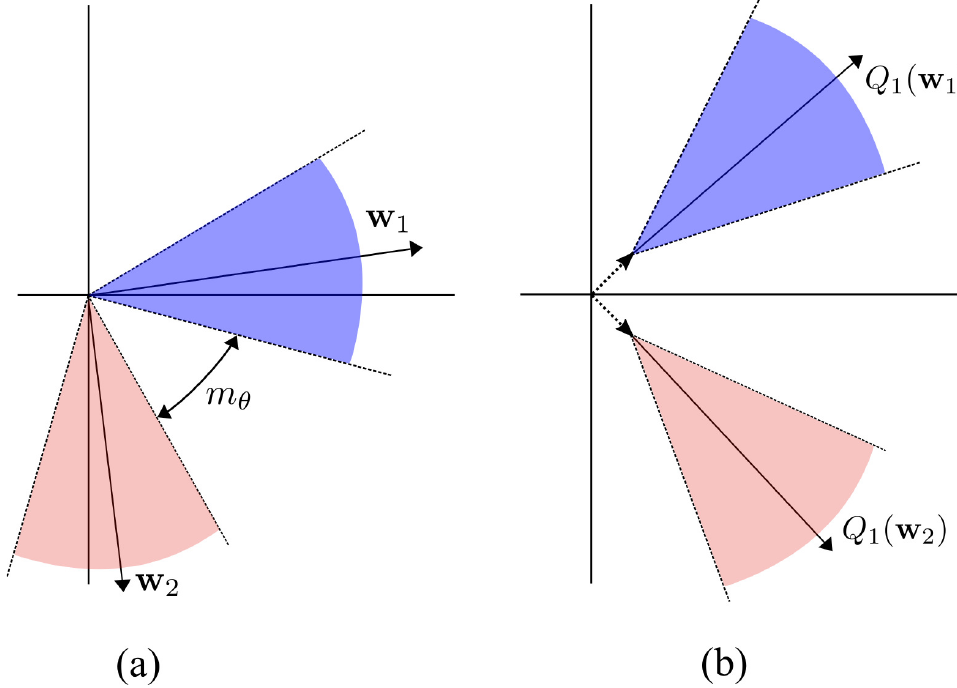
Figure 2. Geometric interpretation of feature space learned by a softmax-based loss function ( a ) with- out and ( b ) with Orthant loss,